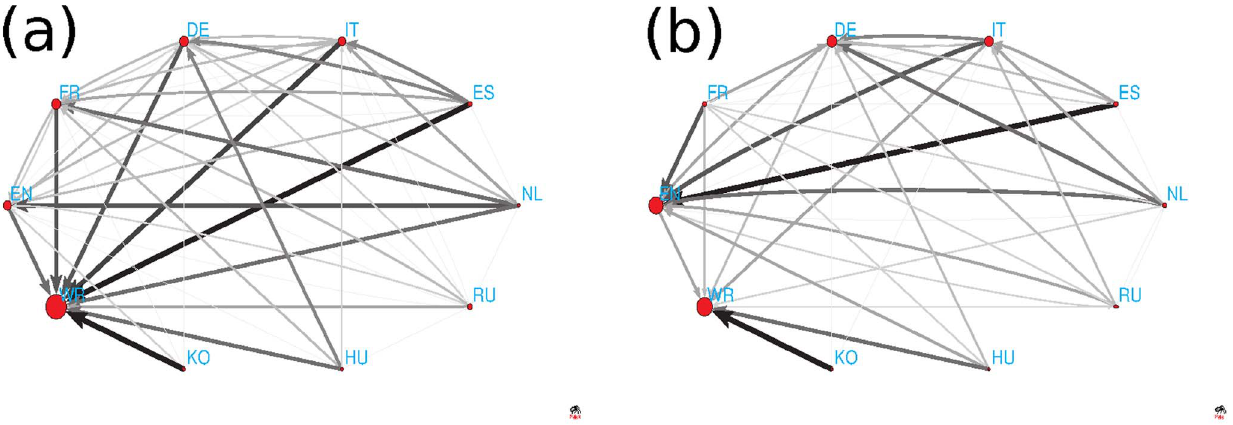
Figure 5. Network of cultures obtained from 9 Wikipedia languages and the remaining world (WR) selecting 30 top persons of PageRank (a) and 2DRank (b) in each culture. The link width and darkness are proportional to a number of foreign persons quoted in top 30 of a given culture, the link direction goes from a given culture to cultures of quoted foreign persons, quotations inside cultures are not considered. The size of nodes is proportional to their PageRank.